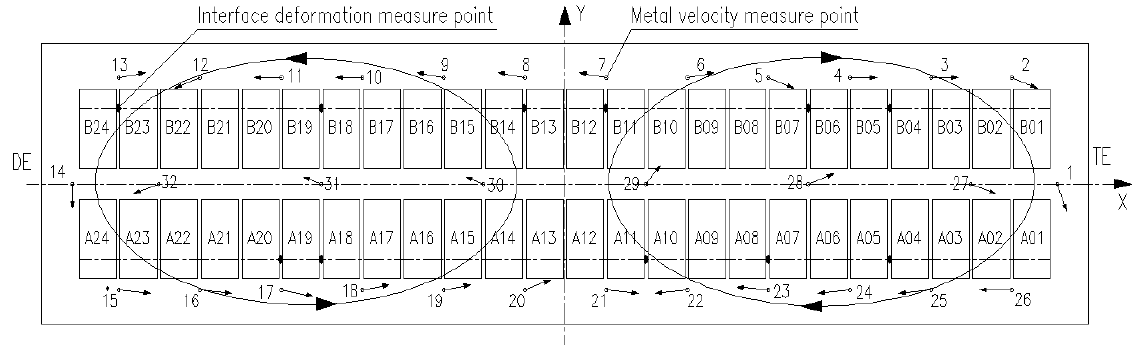
Figure 5. Metal velocity measure points position and flow direction.